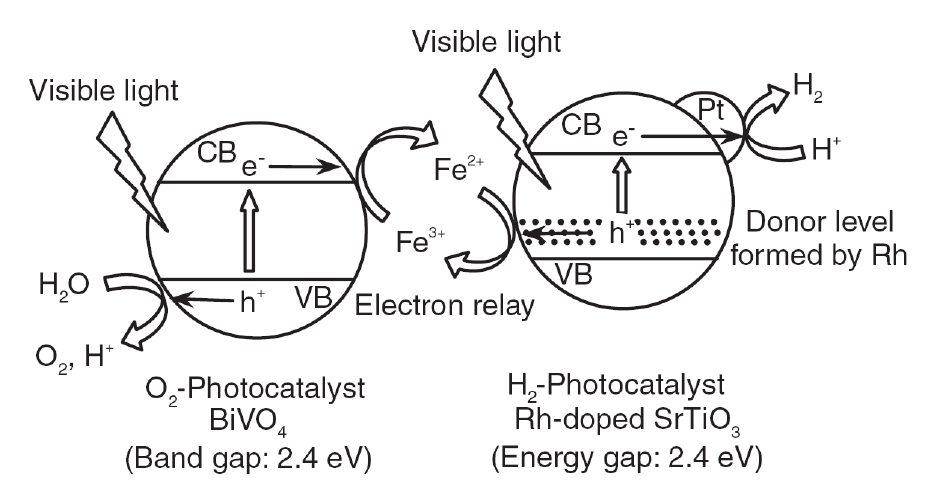
Figure 6. Mechanism of Z-scheme system for water-splitting reaction reprinted from ref [56], Copyright (2008), with permission from